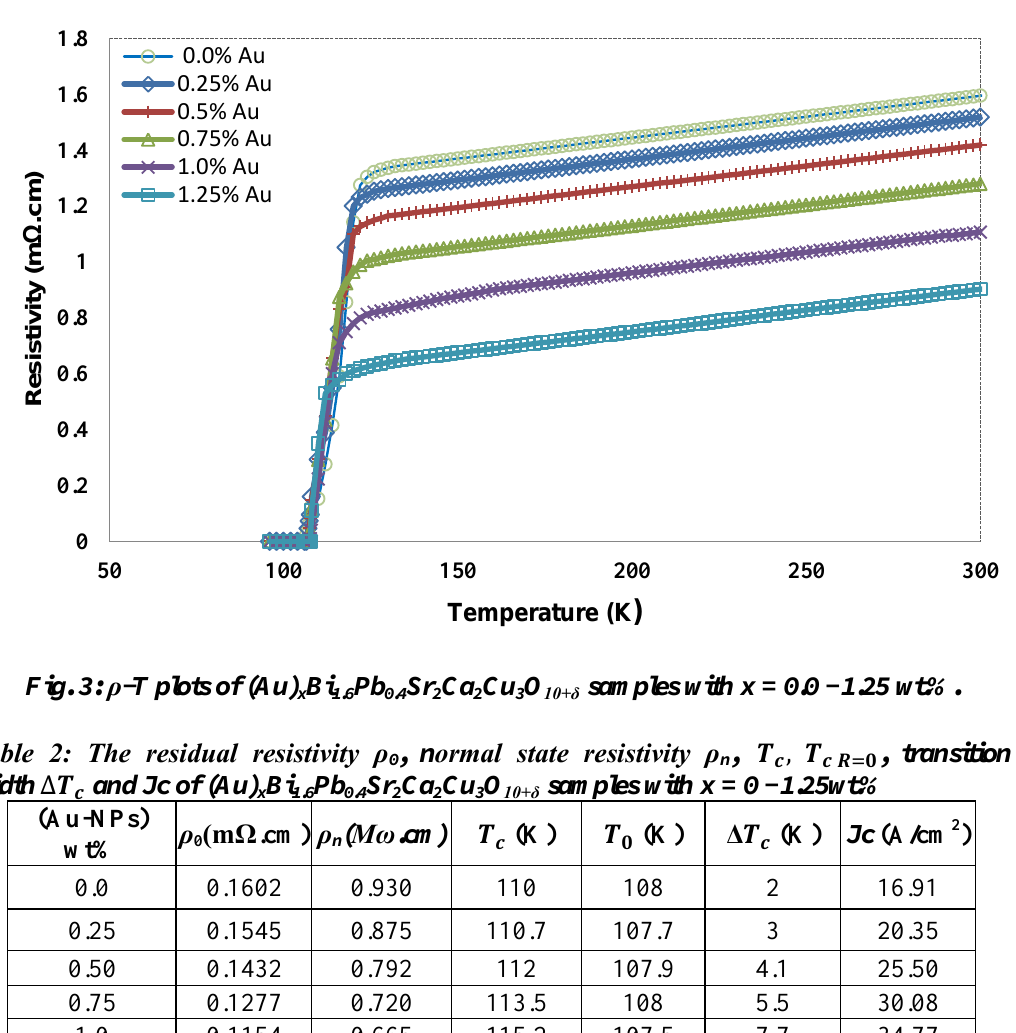
, 𝑻 , transition , 𝑻 𝒄 𝒄 𝑹=𝟎 n